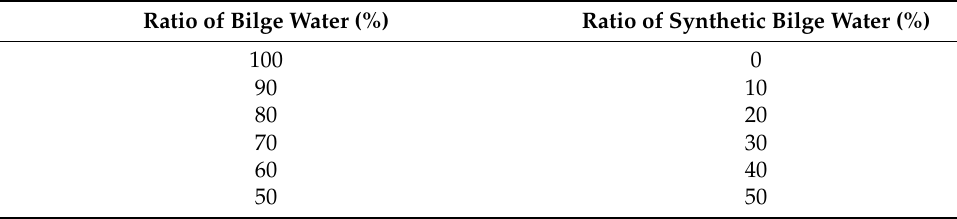
Table 4. Mixing ratio of bilge water and synthetic bilge water for adsorption isotherm